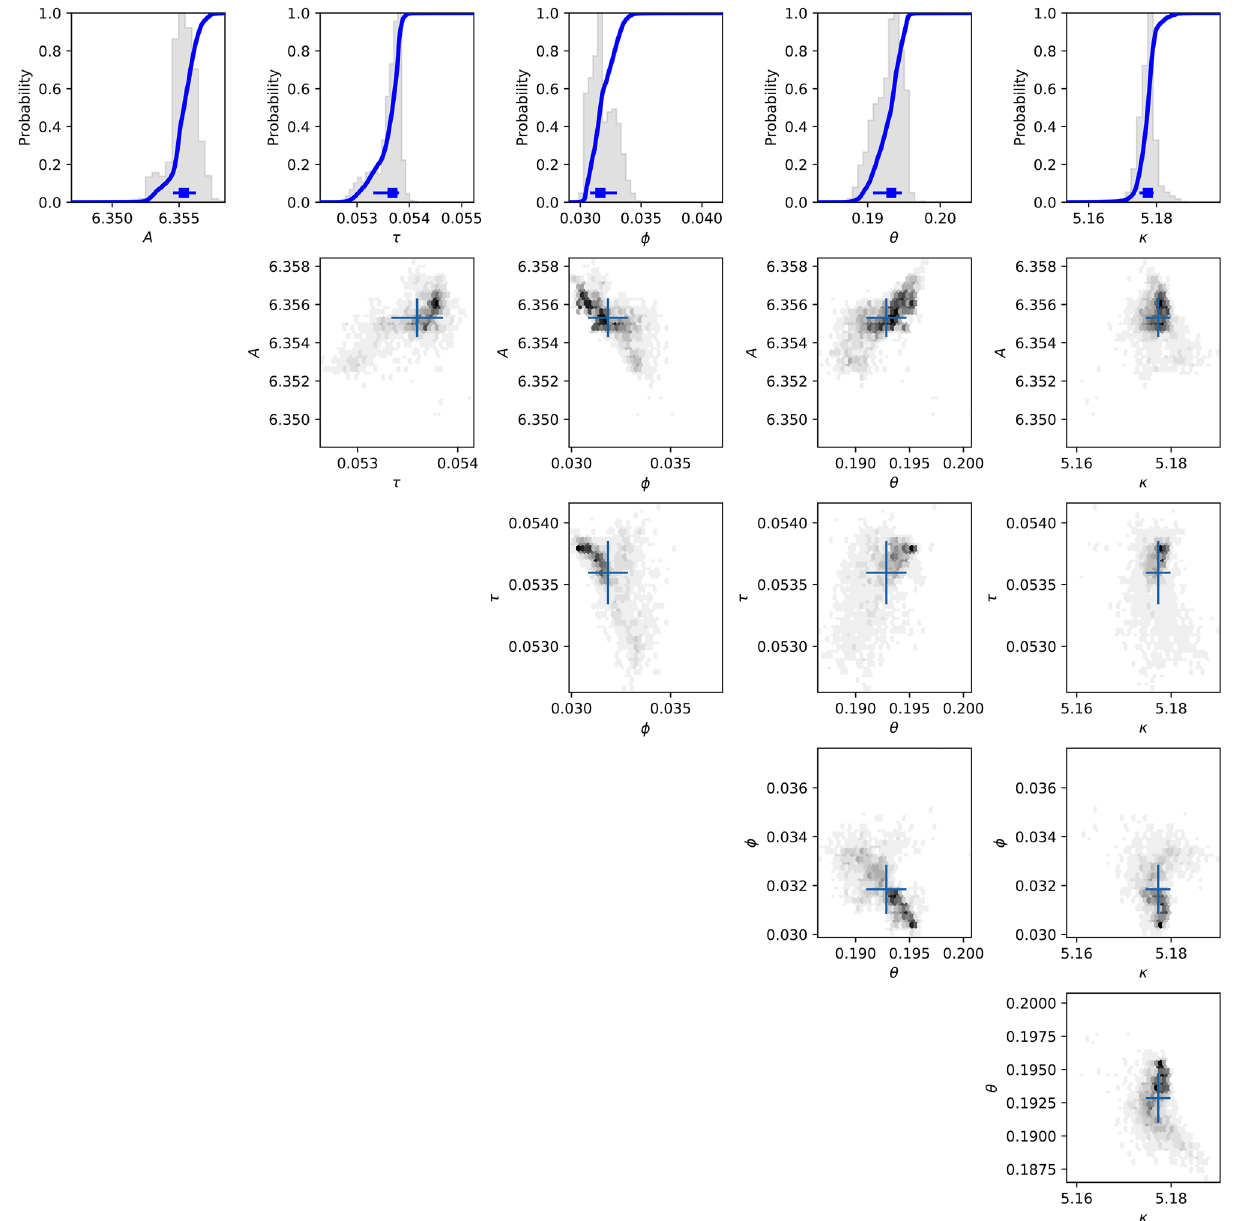
Figure 2. The posterior distribution of the ARMA model parameters is shown in a corner plot of two- dimensional cuts and one- dimensional histograms for Recording 123,136 of the Killer Whale. The distribution has been marginalized over the parameters which are not shown. Blue crosses show the mode of the distribution as identified by the Multinest